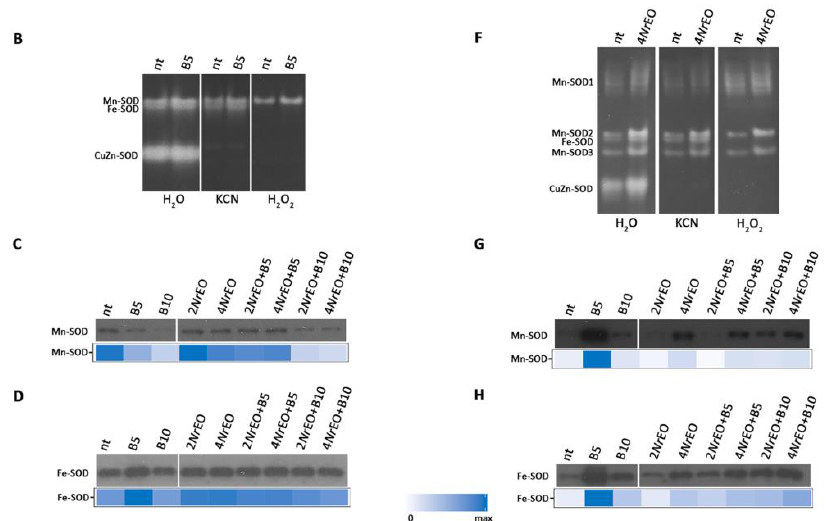
Figure 6. Superoxide dismutase (SOD) activity in Arabidopsis shoots and roots grown in vitro , measured 10 days after treatment with BASTA applied at two concentrations B5 (5 mg L − 1 ) and B10 (10 mg L − 1 ), N. rtanjensis essential oil applied at two concentrations 2% (2 Nr EO) and 4% (4 Nr EO), and of their combinations. Total soluble proteins were extracted from shoots and roots and loaded (5 µg per lane) on 10% gel, separated by native-PAGE and assayed for SOD activity. ( A , E ) The detected activities were measured densitometrically and presented as relative SOD activity (% of control) in comparison to non-treated plants (nt). ( B , F ) Identification of SOD isoforms based on differential sensitivity to hydrogen peroxide and potassium cyanide. ( C – H ) For SDS-PAGE 20 µg of soluble proteins per line from shoots/roots were loaded on 10% gels, transferred to nitrocellulose membranes and immunoblotted using primary antibodies antirabbit MnSOD ( C , G ) and antirabbit chloroplastic FeSOD ( D , H ). Corresponding heat-maps show relative abundances of SOD proteins. Maximal values on the color scales represent maximal values recorded for each immunoblot, independently.